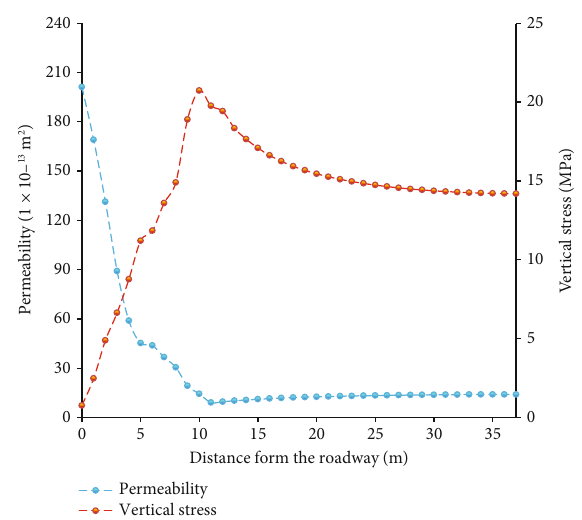
Figure 11: Vertical stress and permeability curves of surrounding